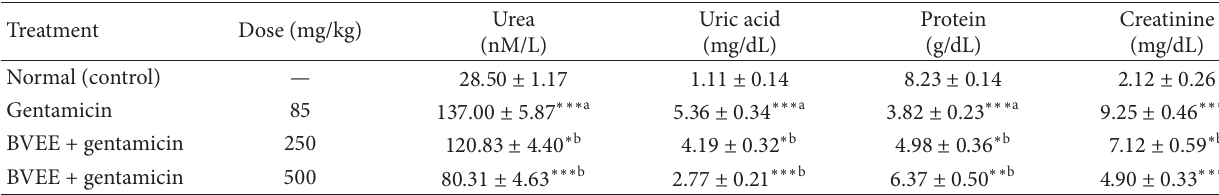
Table 2: Effect of BVEE on nephrotoxicity markers in